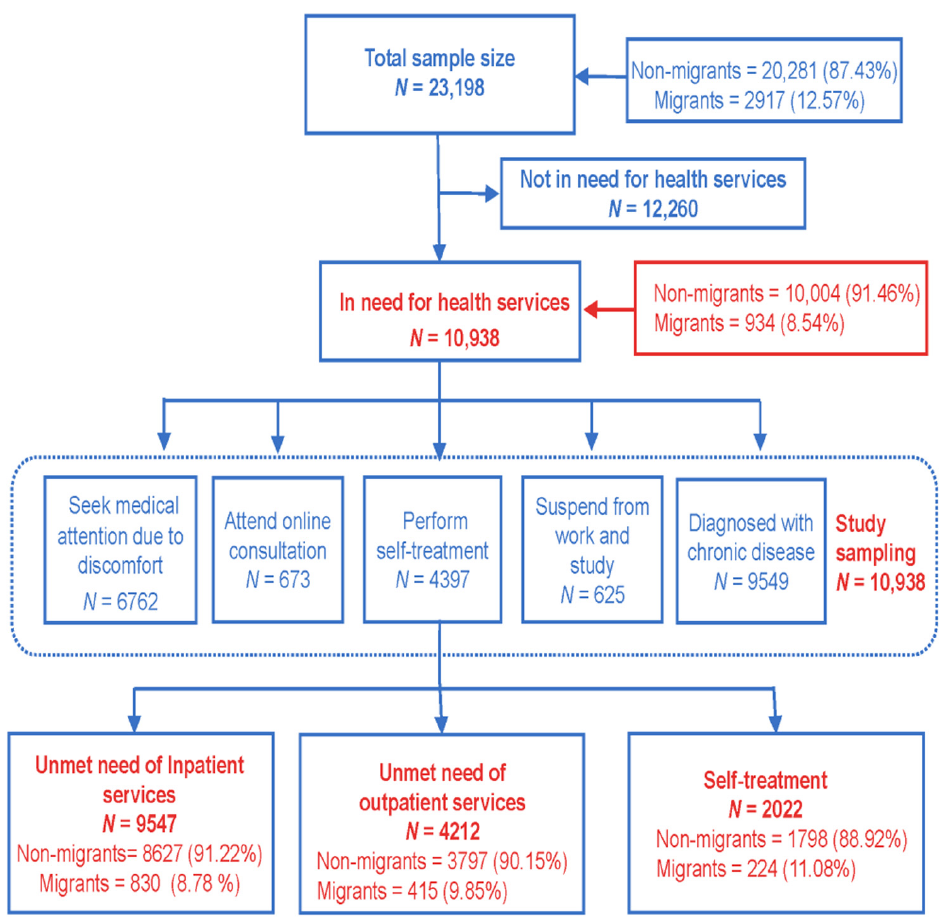
Figure 2. The sample size of the study and their unmet health service needs.